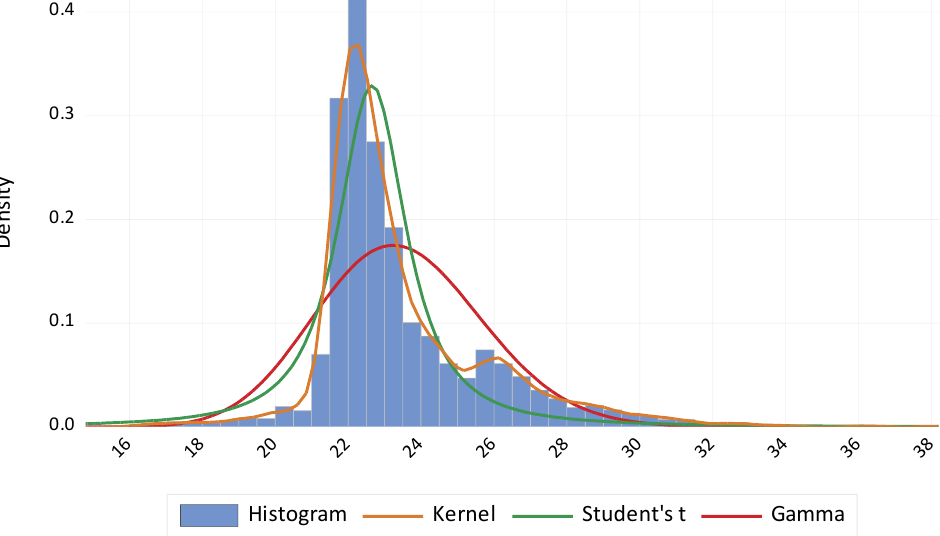
Figure 4. Stochastic Volatility Densities from Observables and the Kalman Filter.